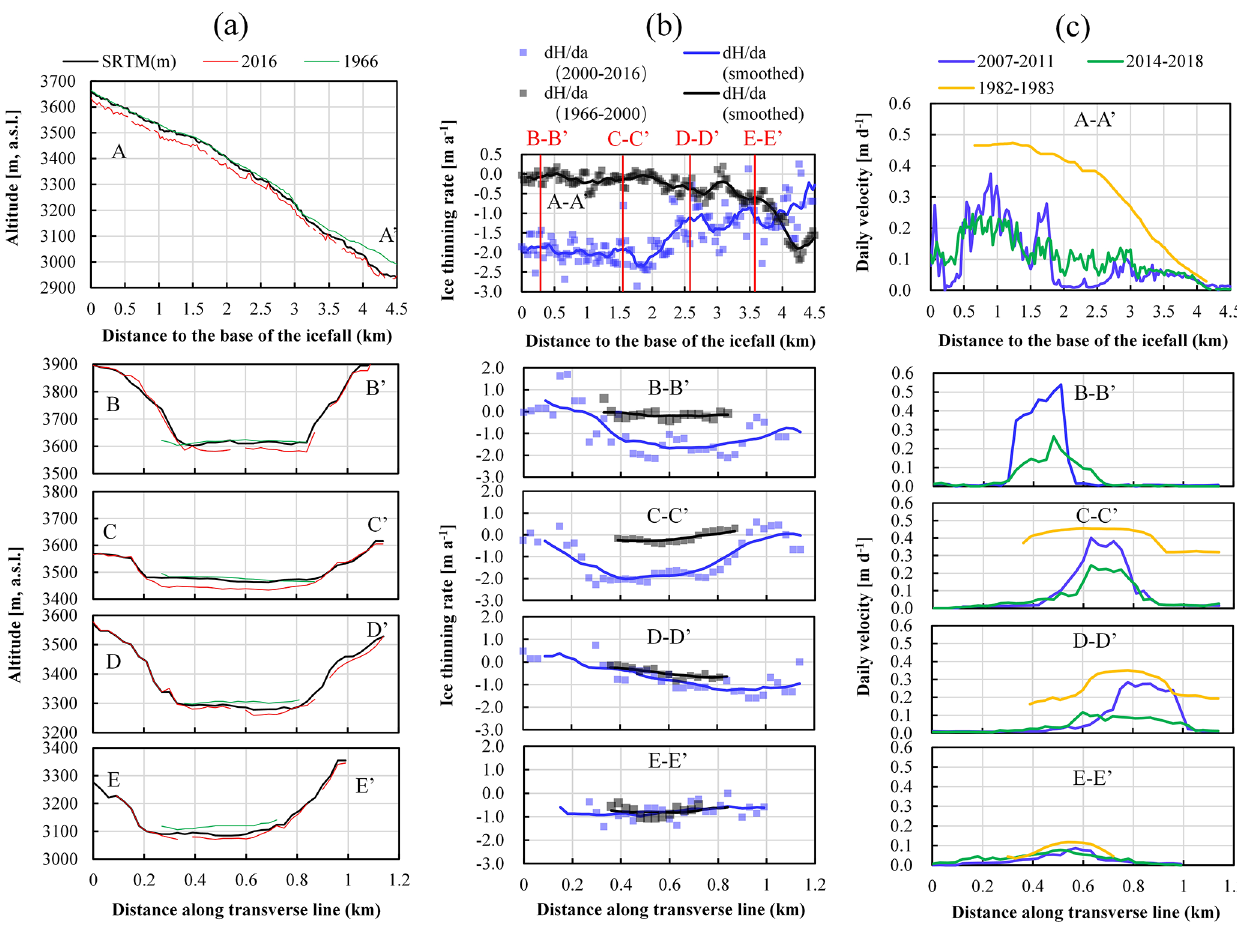
Figure 3. Comparison of ice surface elevations, average annual ice thinning rates (Brun et al., 2017), and velocity changes (G. Liu et